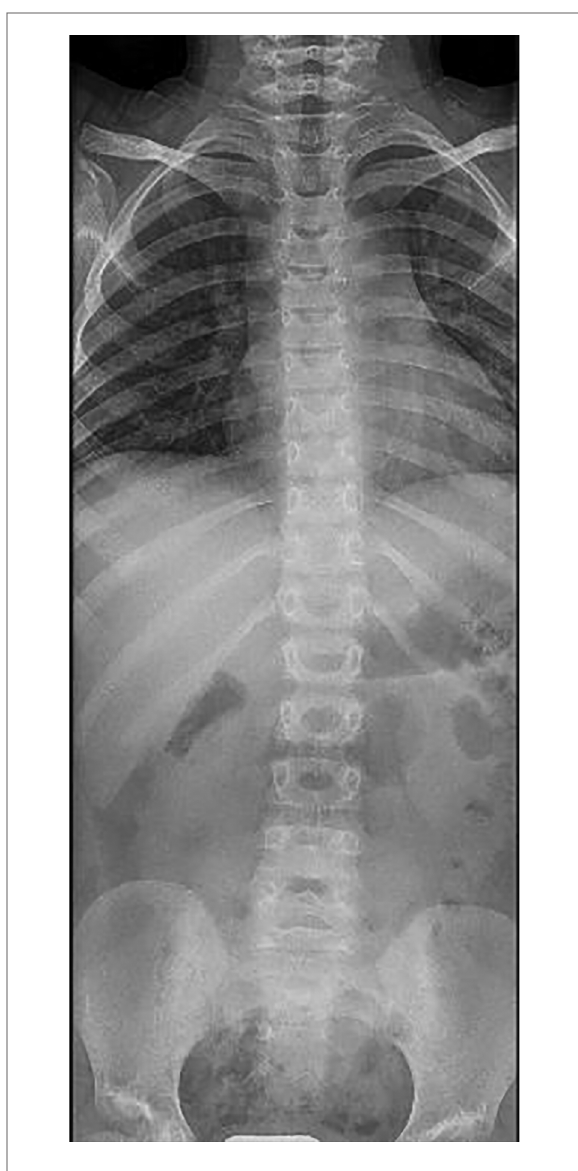
FIGURE 2 Radiography of the spine. X-ray of the spine shows on the coronal plane the presence of wide-radius convex left curvature of the thoracolumbar